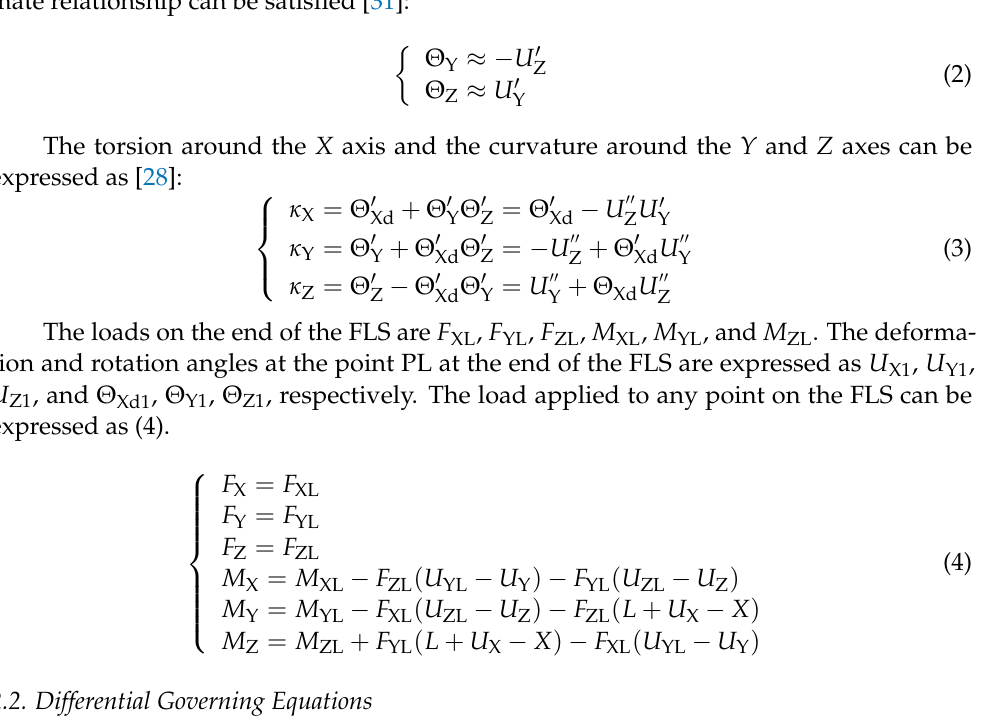
Figure 2. Transformation of the spatial coordinate systems.